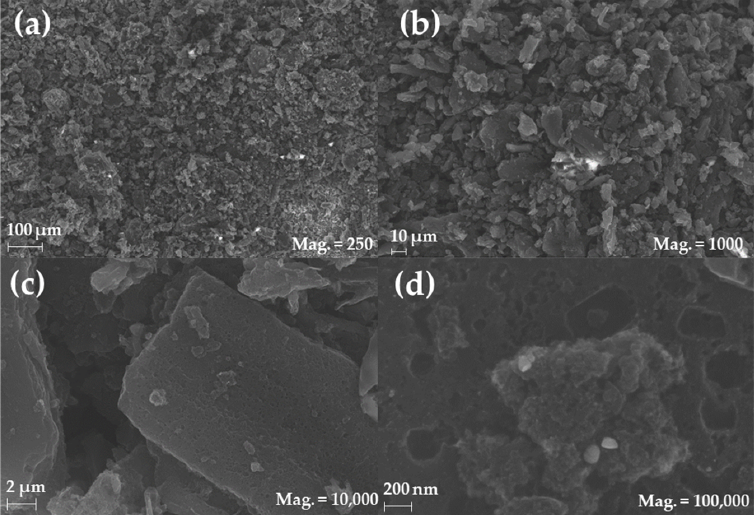
Figure 4. SEM images of the Ir/C catalyst with magnifications from 250 to 100,000, ( a – d ). All images were taken with following parameters: EHT = 20.0 kV, WD = 8.5 mm, SingalA = InLens. Rh/C provides a uniform image of the SEM in Figure 5a,b. Grain sizes can hardly be established, as the particles have ragged edges and are heavily agglomerated. Even at magnifications of 5000, it is impossible for most dimensions to be determined due to the agglomeration of many small particles in the size range of 3.6–6.6 µm. It becomes obvious at magnifications of 10,000 that the material consists of even smaller particles with a fairly narrow qualitative size distribution (see Figure 5c,d). At the highest magnification of 100,000, crater-like structures become visible at the particle surface that could be pore openings in the range of 25–100 nm in size. Overall, this material is made up of the small- est particles compared to all of the other catalytic materials considered in this study.